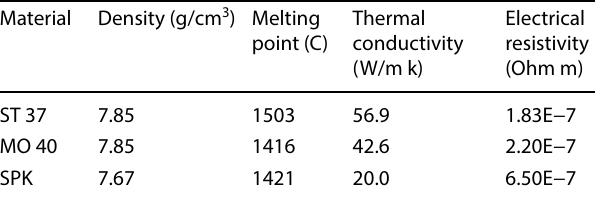
Table 7 Selected properties of the materials were used in the case study Material Density (g/cm 3 ) Melting